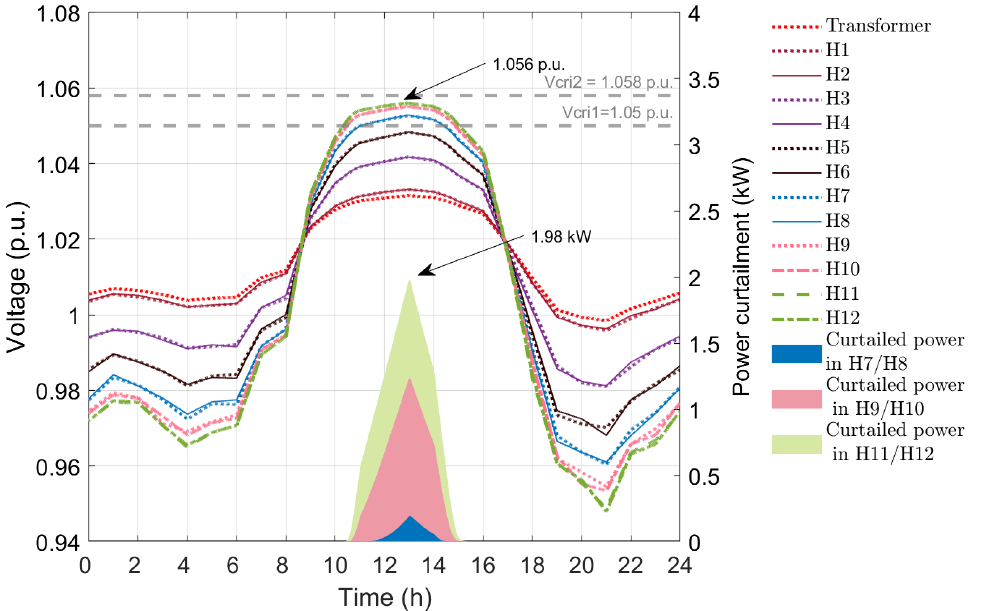
Figure 9. Voltage profile of twelve houses (House 1 to House 12) and curtailed power in APC method with quadratic